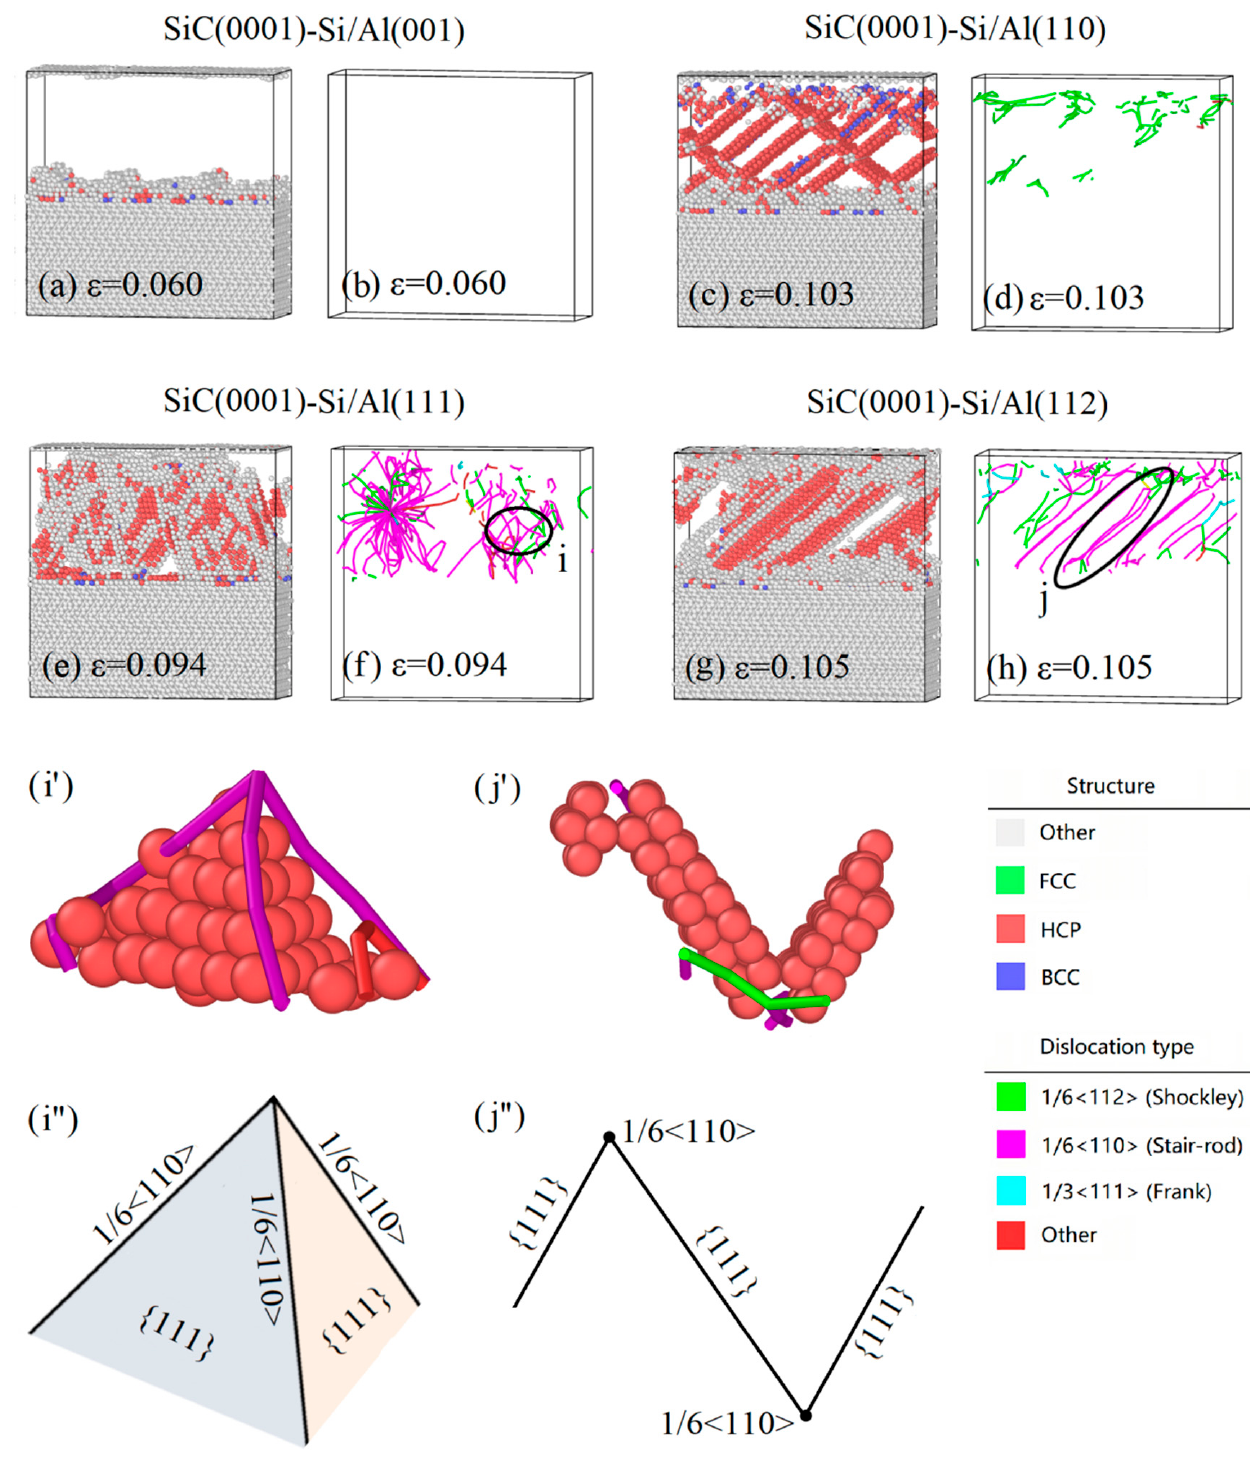
Figure 7. Snapshots of the typical structures and the corresponding dislocation features of ( a , b ) SiC(0001)-Si/Al(001) model, ( c , d ) SiC(0001)-Si/Al(110) model, ( e , f ) SiC(0001)-Si/Al(111) model with ( i,i ′ ,i ″ ) defect configuration found in this model, and ( g , h ) SiC(0001)-Si/Al(112) model with ( j,j ′ ,j ″ ) defect configuration found in this model. The structures are colored using the PTM method. HCP, BCC, and unknown structures are colored red, blue, and white, respectively (with FCC structures neglected). The dislocations are colored using the DXA method. The 1/6 <112> Shockley partial dislocations and 1/6 <110> stair-rod dislocations are colored green and purple, respectively.